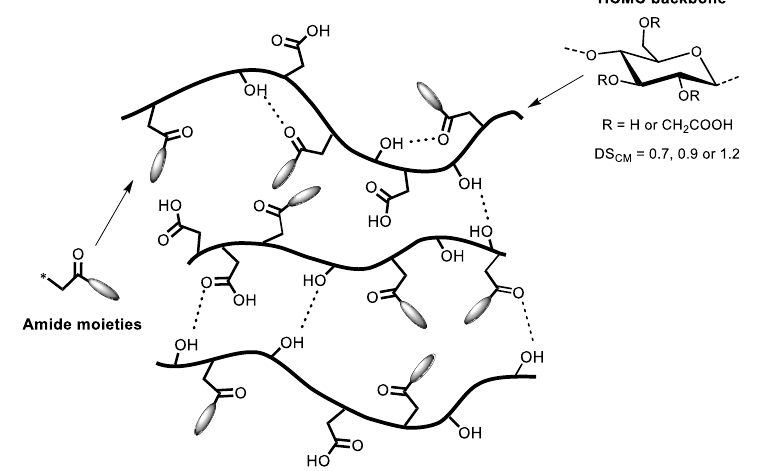
Figure 8. Schematic structure of internally plasticized CMC derivatives.